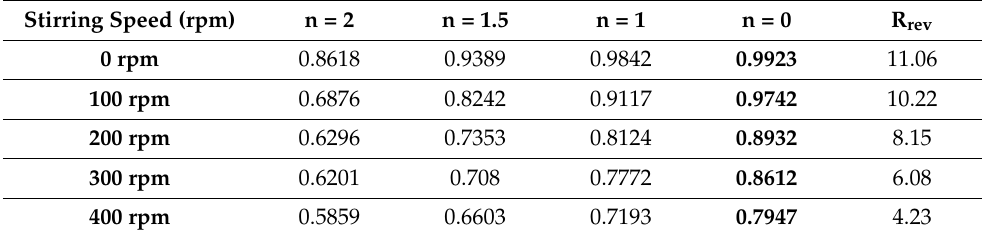
Table 3. R 2 values of Hermia model and reversible resistance ( NMWL = 10 kDa).